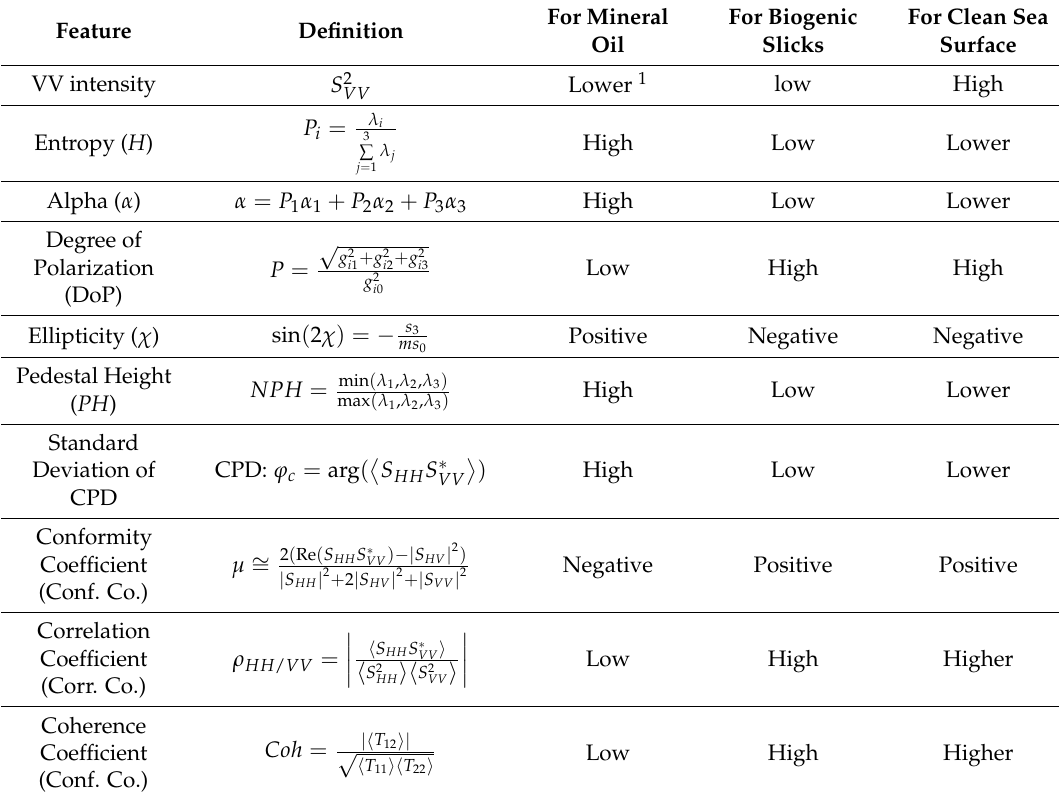
Table 1. Features investigated in this